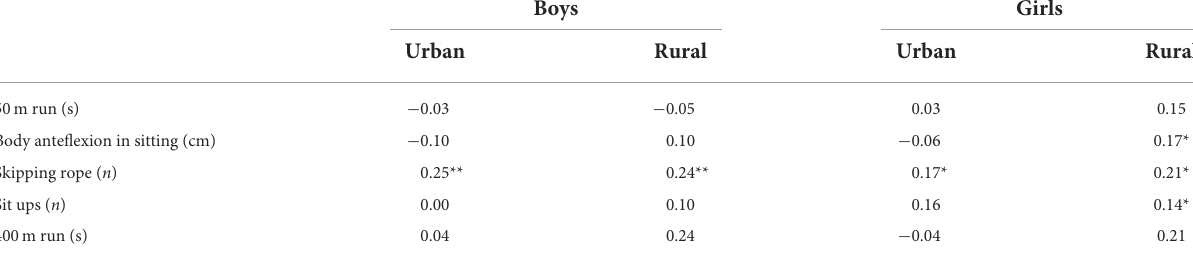
TABLE 2 Correlation between results of 5 items of physical fitness test and arm muscle area (AMA). Boys Girls Urban Rural Urban